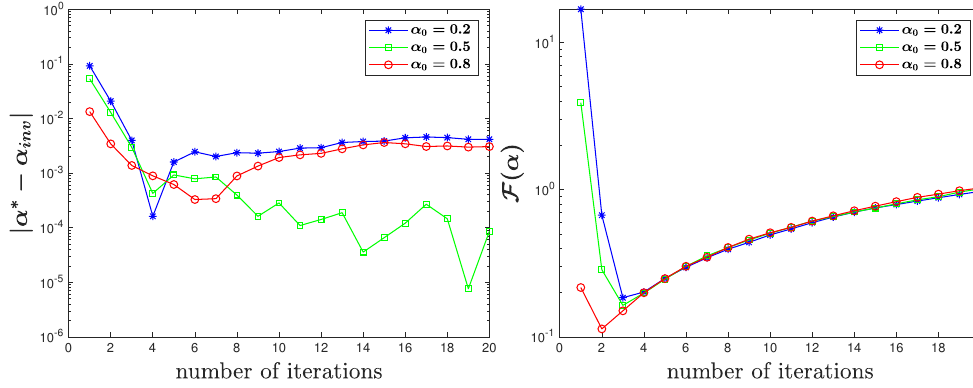
Figure 13. α ∗ = 0.75 for true data with 1% of noise in Test